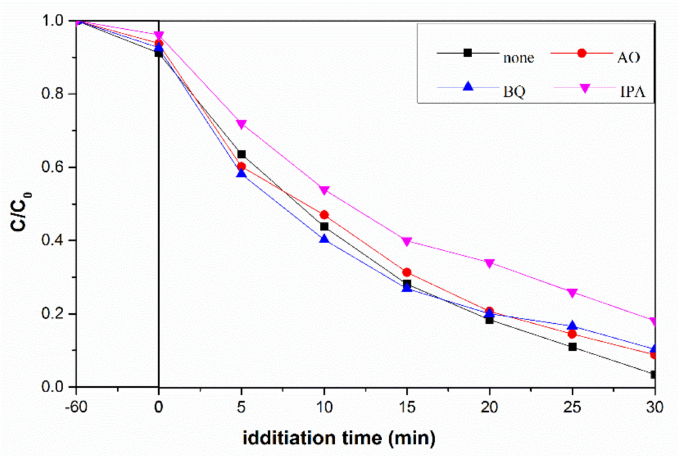
Figure 9. Photodegradation rate of MB by flower-like TiO 2 catalyst with different scavengers under UV-vis light